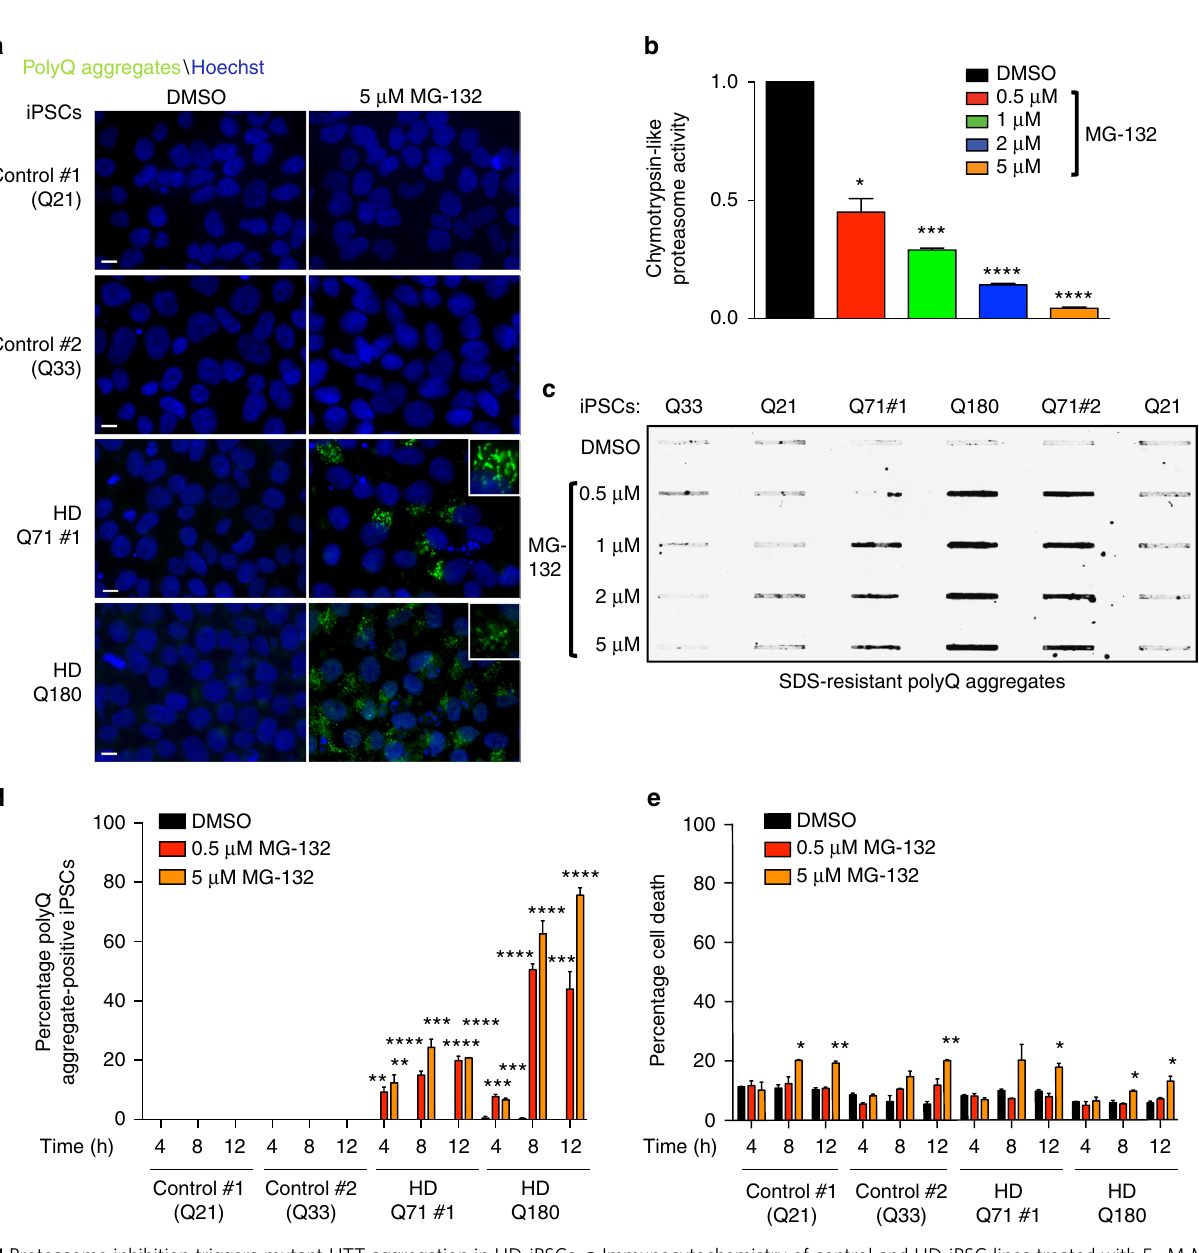
Fig. 1 Proteasome inhibition triggers mutant HTT aggregation in HD-iPSCs. a Immunocytochemistry of control and HD-iPSC lines treated with 5 µ M MG- 132 for 12 h. We used an antibody against polyQ-expanded protein to detect mutant HTT aggregates. Cell nuclei were stained with Hoechst 33342. Scale bar represents 10 μ m. The images are representative of six independent experiments. b Chymotrypsin-like proteasome activity in HD Q180-iPSC line treated with MG-132 for 12 h (relative slope to Q180-iPSCs treated with DMSO). Graph represents the mean ± s.e.m. of three independent experiments. c Filter trap analysis of the indicated control and HD-iPSCs. Proteasome inhibition with MG-132 for 12 h results in increased levels of polyQ aggregates in HD-iPSCs lines (detected by anti-polyQ-expansion diseases marker antibody). However, proteasome inhibition does not induce accumulation of polyQ aggregates in control iPSC lines. The images are representative of fi ve independent experiments. d Graph represents the percentage of polyQ aggregate- positive cells/total nuclei in the indicated iPSC lines (mean ± s.e.m., 3 independent experiments, 300 – 350 total cells per treatment for each line). e Graph represents the percentage of propidium iodide-positive cells/total nuclei in the indicated iPSC lines (mean ± s.e.m., 3 independent experiments, 500 – 600 total cells per treatment for each line). For each time point, MG-132-treated lines were statistically compared with their respective DMSO-treated line. All the statistical comparisons were made by Student ’ s t -test for unpaired samples. * P < 0.05, ** P < 0.01, *** P < 0.001, **** P <